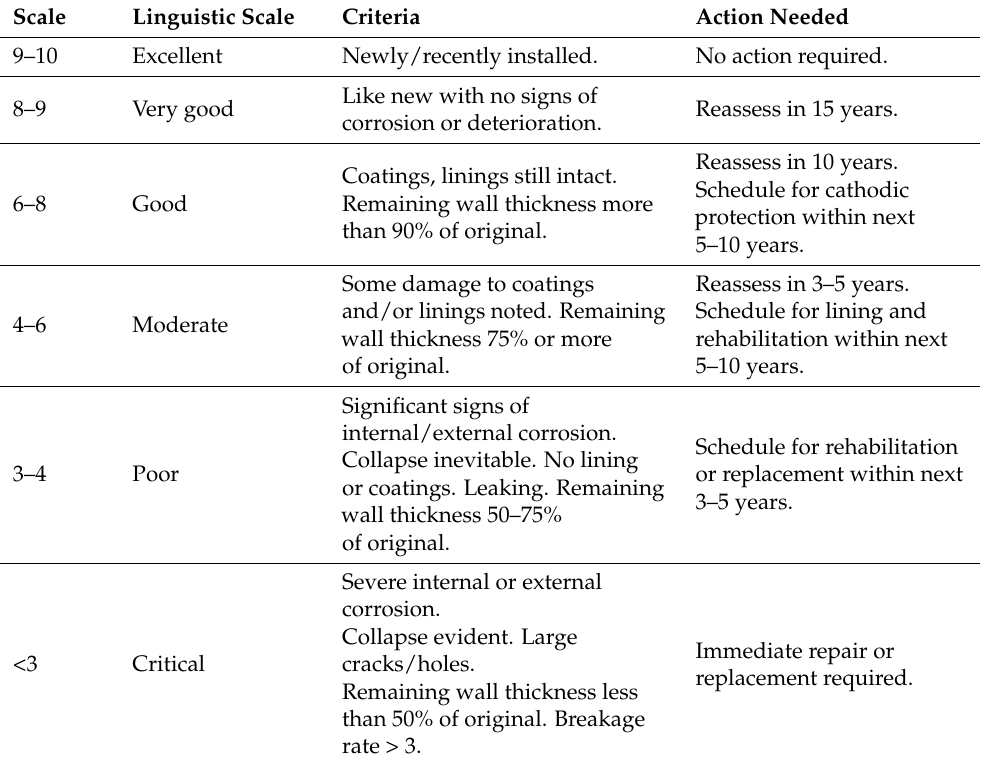
Table 1. Condition scores used to rate the irrigation infrastructure at the Agri-Parks, Gauteng province (adopted from